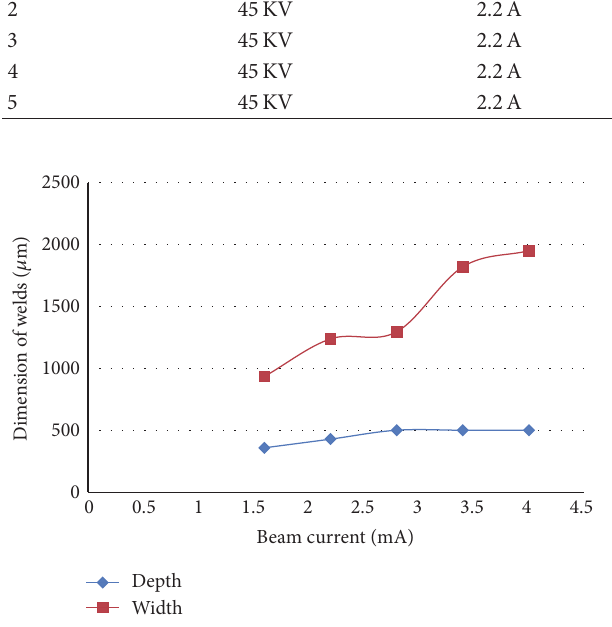
Figure 4: The effect of beam current on welds geometry.